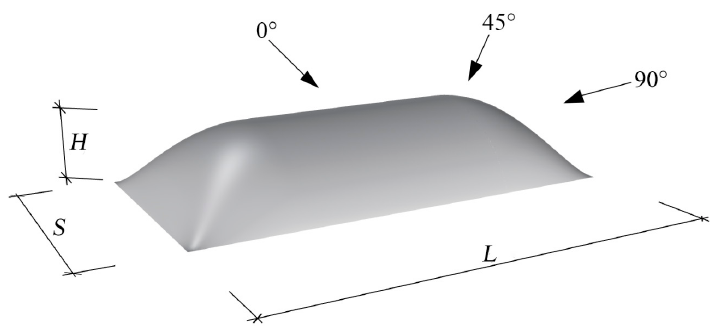
Figure 11. Details of the inflatable membrane structure and wind direction.